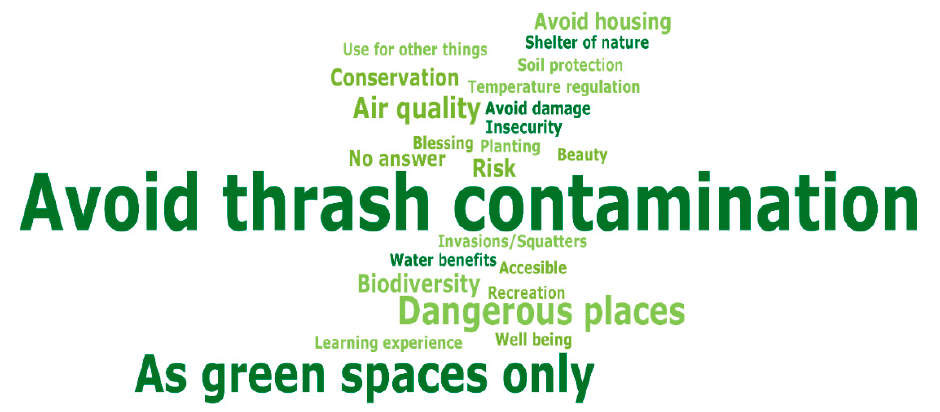
Figure 8. Comparison between citizen’s perception and actual amount of public green spaces in zones of Guatemala City. In the center the zones of Guatemala City. To the left the bars show the proportion of public green spaces area from each zone total area. To the right, bars show the proportion of mentions of each zone, which the citizens perceived with more amount of green spaces. Data was standardized using min-max normalization.